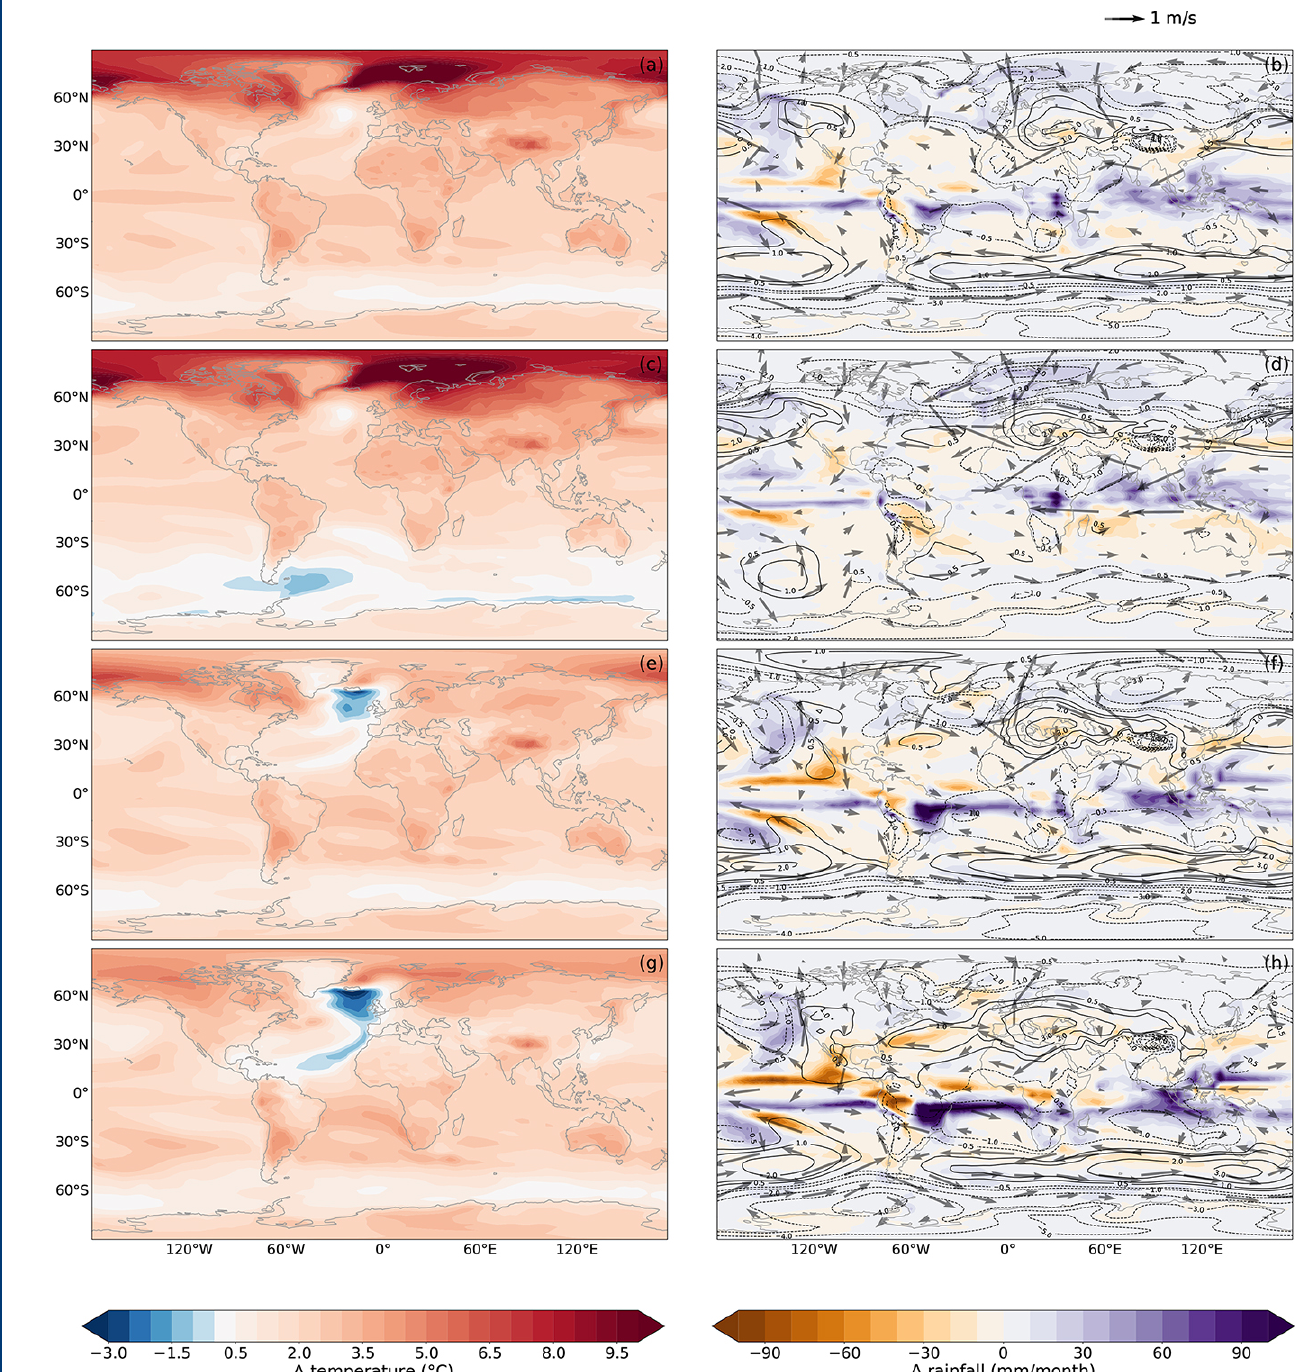
Figure 5. Difference between future scenarios (2041–2070) and historical simulation (1976–2005) for the boreal winter season (NDJFM). The left column depicts the surface temperature difference (a, c, e, g) , and the right column shows the difference in rainfall (shading), SLP (black contours, dashed lines for negative values) and wind at 850hPa (vectors) (b, d, f, h) . The future scenarios are (a, b) RCP85, (c, d) WAIS3m, (e, f) GrIS1m and (g, h) GrIS3m.